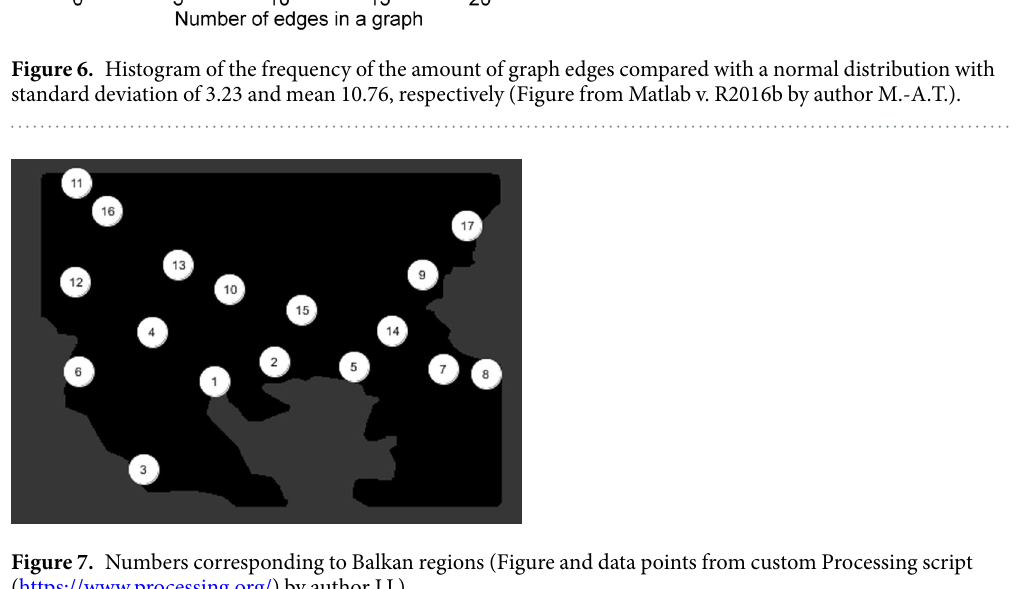
and ‘bottom-up’ interactions, as opposed to the ‘top-down’ network constructs formed from classical algorithmic approaches. We use the multi-agent approach that was introduced in 47 to approximate the emergent transport networks of slime mould. This approach has been demonstrated to be useful for approximating the biological behaviour of slime mould 48, 49 , and in developing biologically inspired unconventional computing methods 50 . A population of mobile particles is created and initialised on a 2D lattice configured to the experimental arena of the Balkans region. The diffusive medium is represented by a discrete two-dimensional floating point lattice. Particle positions are stored on a discrete lattice isomorphic to the diffusive lattice. Particles also store internal floating point rep- resentations of position and orientation which are rounded to discrete values to compute movement updates and sensory inputs. A single particle, and an aggregation of particles, are related to the P. polycephalum Plasmodium in the following way: the Plasmodium is conceptualised as an aggregate of identical components. Each particle represents a hypothetical unit of gel/sol interaction. Gel refers to the relatively stiff sponge-like matrix composed of actin–myosin fibres and sol refers to the protoplasmic solution which flows within the matrix. The structure of the protoplasmic network is indicated by the particle positions and the flux of sol within the network is rep- resented by the movement of the particles. The resistance of the gel matrix to protoplasmic flux of sol is gener- ated by particle movement collisions. For a more detailed description of the model implementation, refer to the Supplementary Information and ref. 50. Representation of landscape arena in the model. Regions are denoted by the aforementioned numer- ical list and correspond to the areas in Fig. 7. We used two different landscape representations as the arenas for the model Plasmodium. The first has no heightfield representation of the landscape topography and contains only the borders of the region and nutrient attractant sites at the corresponding regions (Fig. 8(a)). The second representation contains the same region rep- resented as an 8-bit greyscale heightfield map where pixel intensity corresponds to topographic height (Fig. 8(b)). This data was generated using the Whitebox Geospatial Analysis Tools program which (when specifying latitude and longitude coordinates bounding the Balkans region) builds a greyscale heightfield map based upon geological terrain sampled by satellite surveying methods (see 51 for more information).